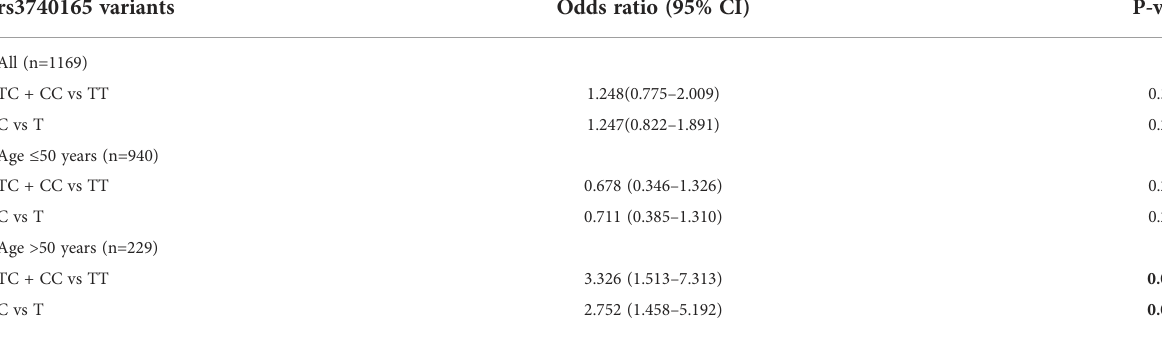
TABLE 4 The rs3740165 variants and the risk of hyperuricemia (UA >420 m mol/L).